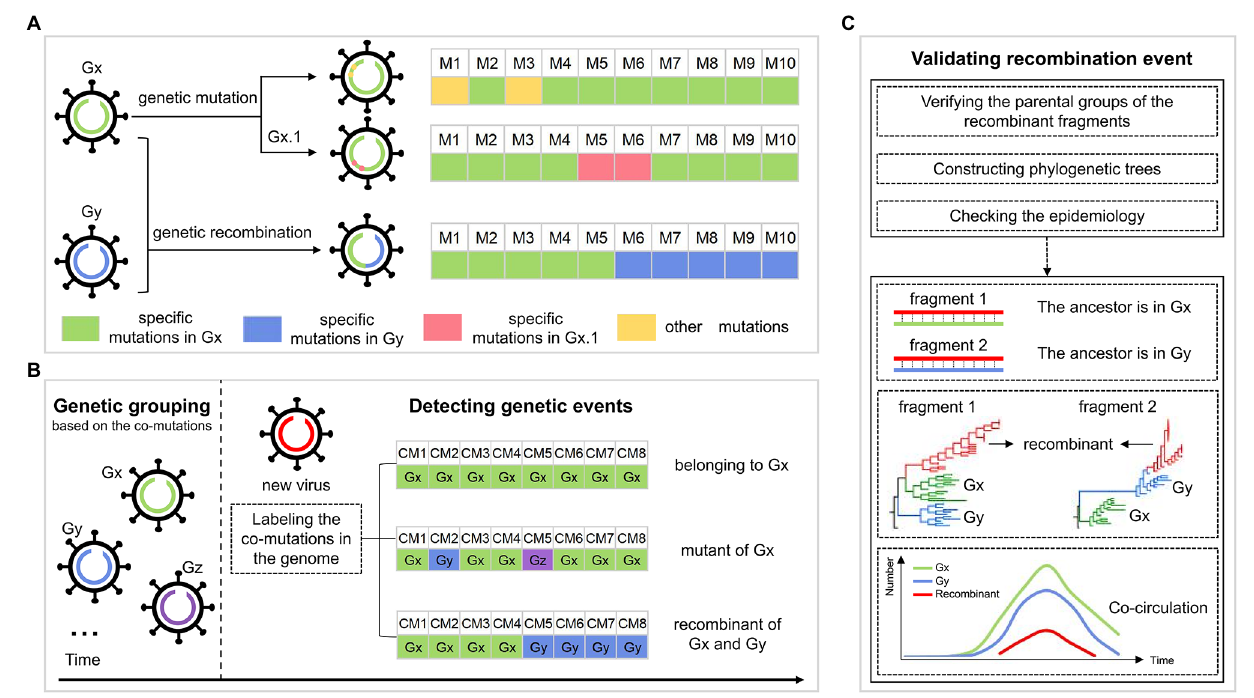
FIGURE 1 | The workflow for identifying the genetic events during SARS-CoV-2 evolution. (A) The possible evolutionary pathways of SARS-CoV-2 viruses. Gx and Gy are two genotypes, each corresponding to a set of specific mutations, whose genomes are colored green and blue, respectively. Viruses in each genotype could evolve in two ways, including genetic mutation and genetic recombination. For genetic mutation, the descendant inheriting the specific mutations of its parental genotype has some new mutations that may be rare, or may be dominant to form a sub-genotype Gx.1. For genetic recombination, the descendant (virus with the green and blue genome) inherits mutations from the parents Gx and Gy, leading to the structure of the crossover site. (B) Detection of the genetic events in the SARS-CoV-2 genomes. The SARS-CoV-2 population is first classified into multiple groups, such as Gx, Gy, and Gz, each corresponding to a genotype with a set of specific co-mutations. For a new virus (virus with red genome), we label the co-mutations (CM) occurring in its genome as the corresponding group. There are three cases: (i) all the co-mutations are labeled as the same group “Gx,” indicating that the virus belongs to Gx; (ii) the largest number of the detected co-mutations come from Gx, and co-mutations from other groups are sporadic and are distributed irregularly, indicating that the virus is a mutant of Gx; (iii) the co-mutations come from different groups (Gx and Gy), where “Gx” and “Gy” both form the block structure, showing that the virus is a recombinant of Gx and Gy. (C) Validation of the detected recombination events. Validation is done in three ways: (i) verification of the parental groups of recombinant fragments; (ii) the topology of phylogenetic trees of recombinant region and non-recombinant region; and (iii) the spatial–temporal distribution of the parental